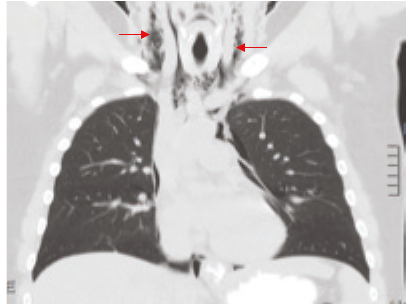
Figure 3: CT chest demonstrating extension of air in the cervical region.